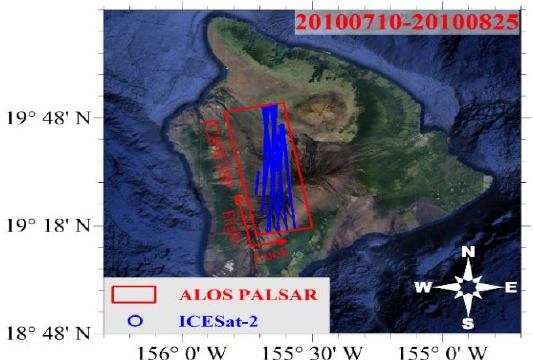
Figure 2. Coverage of the ALOS-1 PALSAR data and the spatial distribution of Ice, Cloud, and land Elevation Satellite-2 (ICESat-2) altimetry data over this study area. The optical image was downloaded from Google